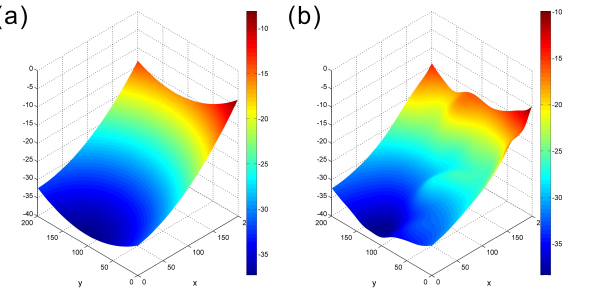
Figure 5. Generation of fault surfaces. ( a ) Ellipsoidal surface. ( b ) Random